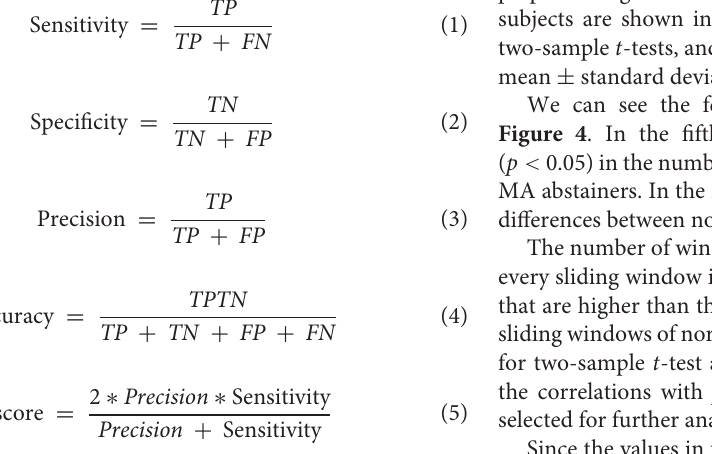
classification. Fivefold cross-validation was used and the metrics of the five times were averaged as the total results. The feature matrices of all participants were divided into five parts. Four parts were selected as the training set and the remaining part was used as the test